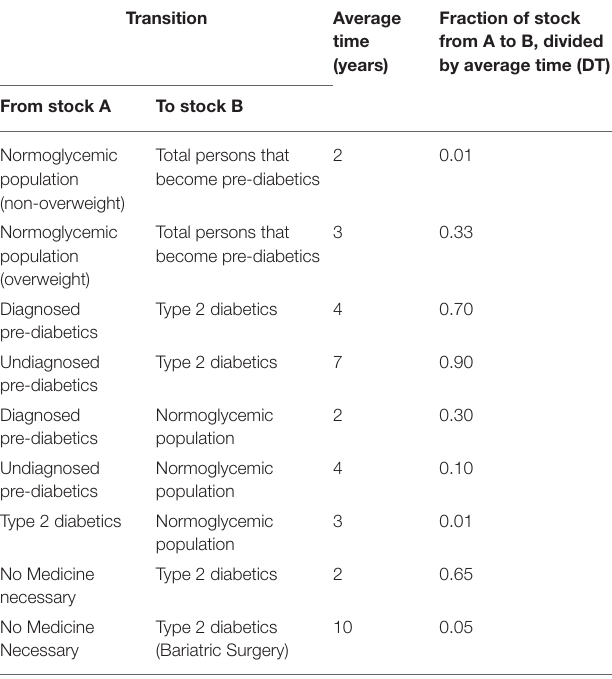
TABLE 1 | Model values used that determine the time and fraction of individuals to transit from one stock to another. Transition Average Fraction of stock time from A to B, (years)